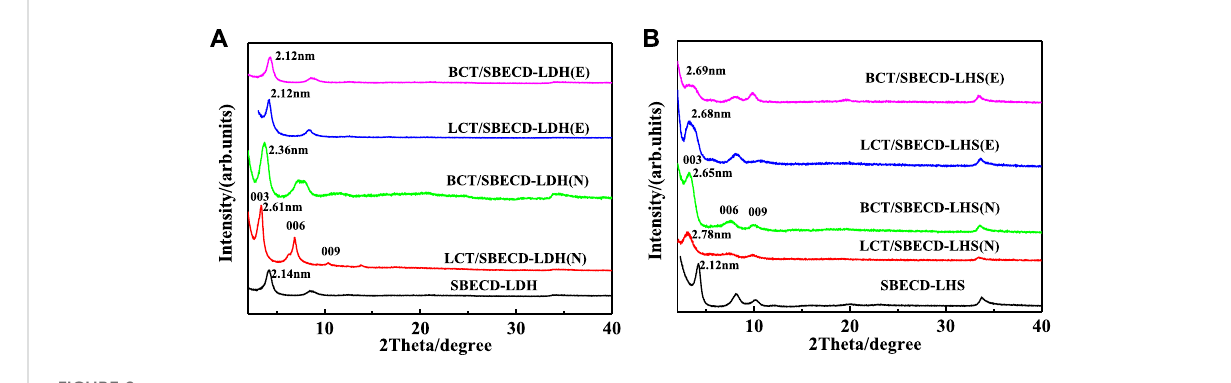
FIGURE 2 XRDpatternsofBCT(LCT)/SBECD-LDH (A) andBCT(LCT)/SBECD-LHSsamples (B) EandNinparenthesesdenotethesolventethanolandNMP used in the synthesis of the sample,